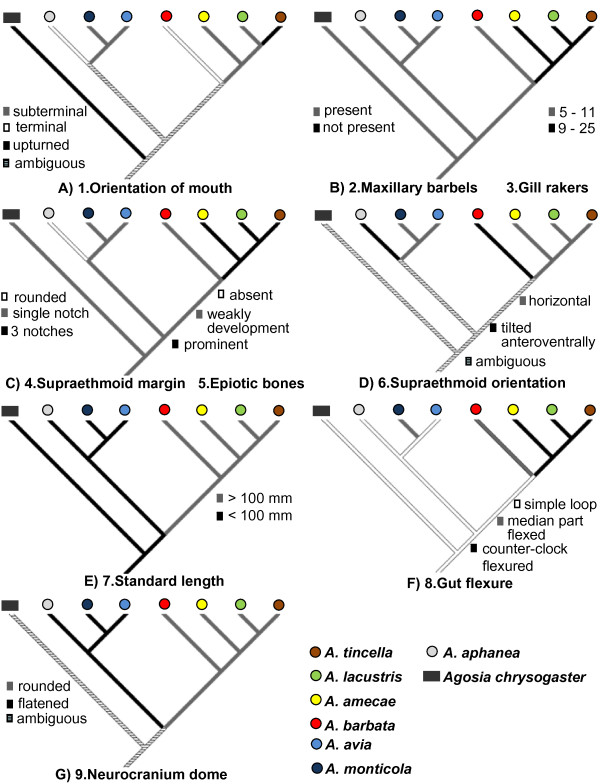
Ancestral character-state mapping on the combined hypothesis of Algansea. A) 1. orientation of mouth; B) 2. maxillary barbels and 3. gill rakers; C) 4. supraetmoid anterior margin and 5. Epiotic bones; D) 6. supraethmoid orientation; E) 7. standard length; F) 8. gut flexure; and G) 9. Neurocranium dome. All character-state codes were based on Barbour and Miller (1978), except supraethmoid orientation, which was based on Jensen and Barbour (1981), and standard length, which was recoded in the present study.